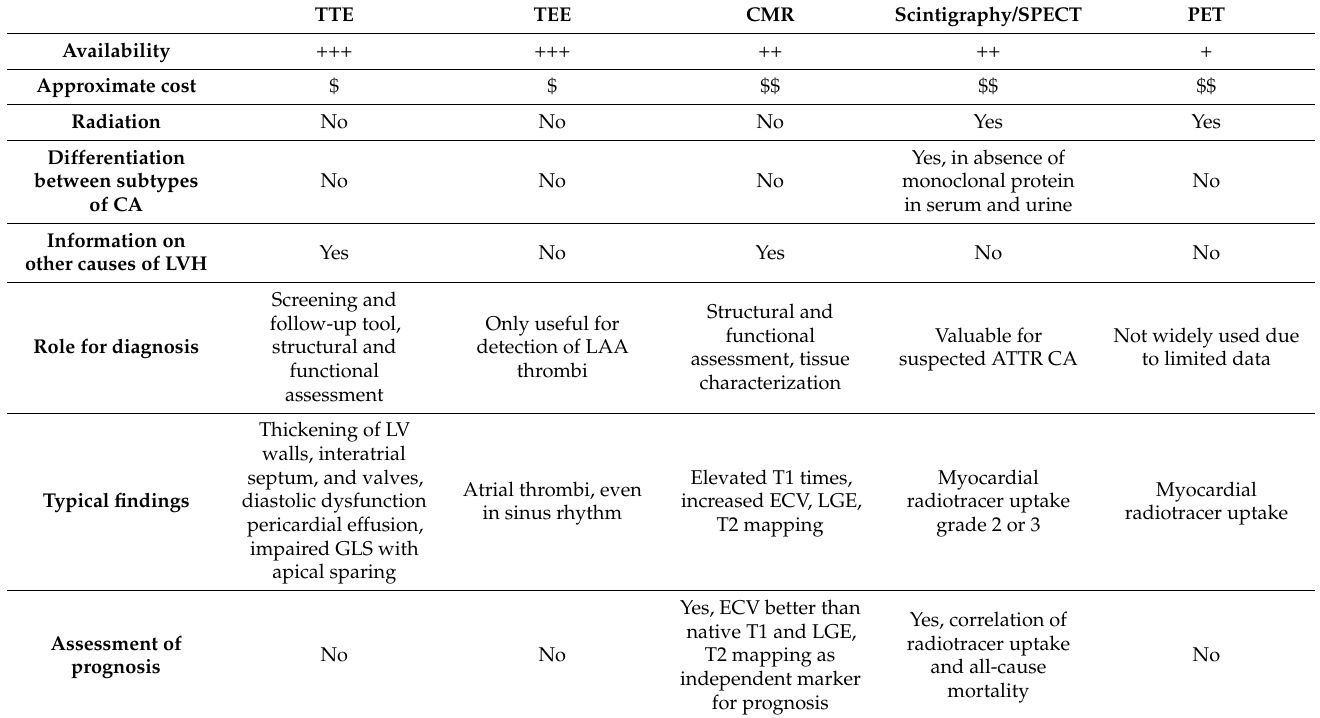
Table 1. Summary of imaging modalities and their features. CMR